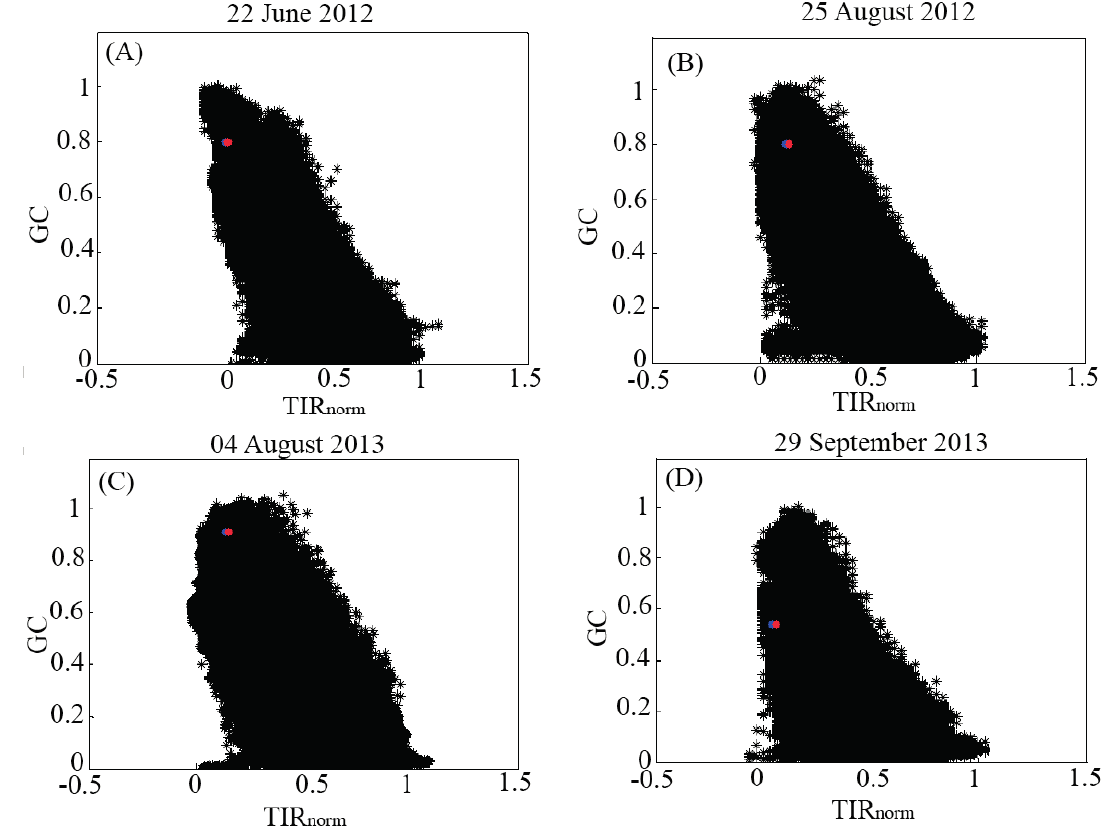
Figure 7. Comparison between TIR norm and T s , norm for the ( A ) 22 June 2012; ( B ) 25 August 2012; ( C ) 04 August 2013; ( D ) 29 September 2013 image acquisitions. The blue mark indicates the TIR norm value while the red mark indicates the T s , norm